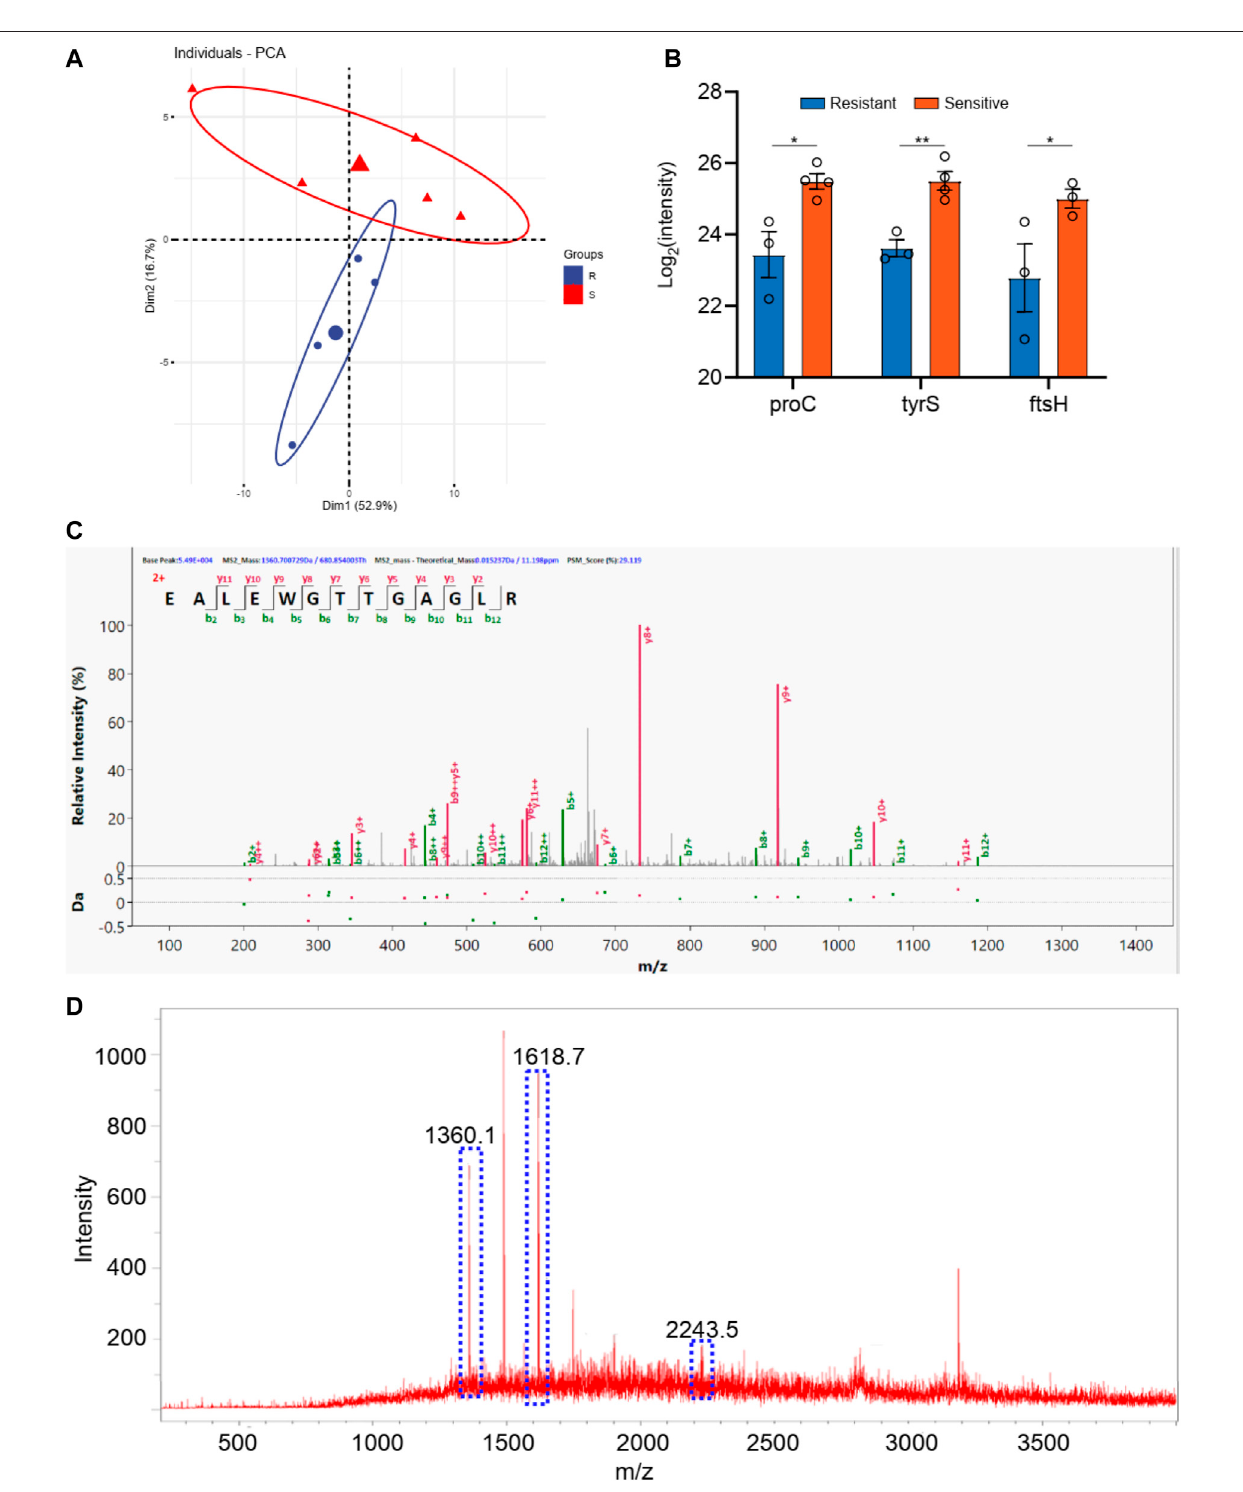
FIGURE 3 | (A) The PCA analysis of drug resistance of ceftazidime for Klebsiella pneumonia ; (B) The differential proteins between drug resistance group and drug sensitive group; (C) The corresponding differential peptides and (D) the fi nger print in MALDI TOF.